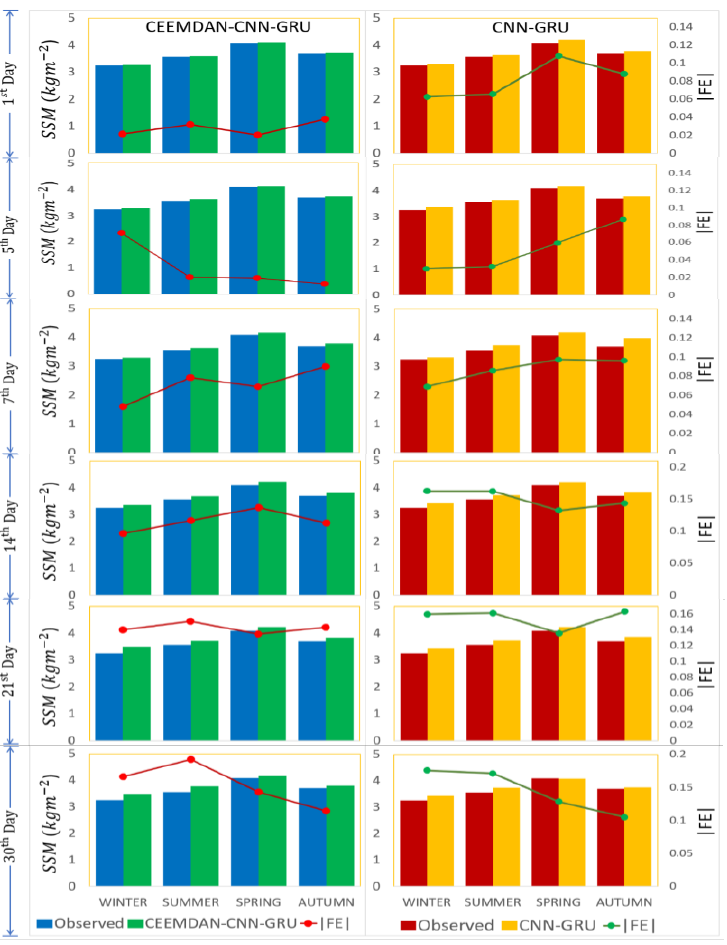
Figure 13. The average forecasted SSM vs. observed SSM on a seasonal basis using hybrid CEEMDAN-CNN-GRU and CNN-GRU models for Menindee at different n th ( n = 1, 5, 7, 14, 21, and 30) day ahead periods. The forecast error (|FE|) in each model is plotted on a secondary axis as a line chart.